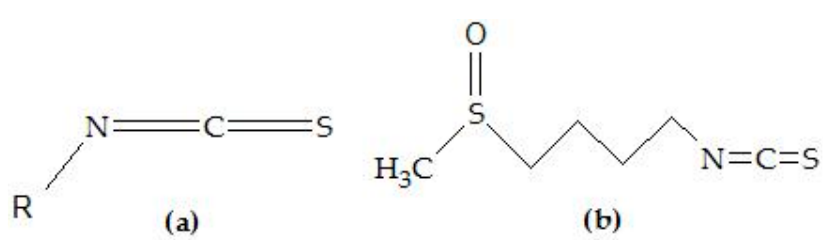
Figure 1. Chemical structures of ( a ) isothiocyanates (ITCs) and ( b ) sulforaphane (SFN).